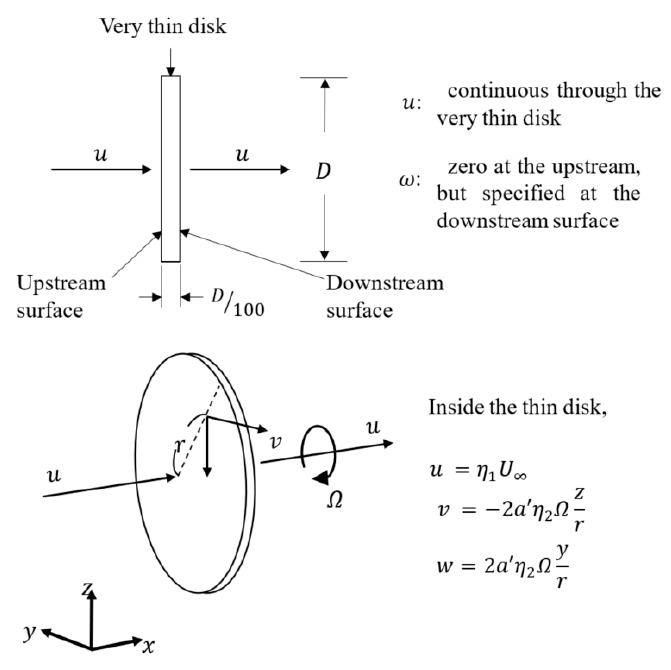
Figure 3. Disk boundary conditions.